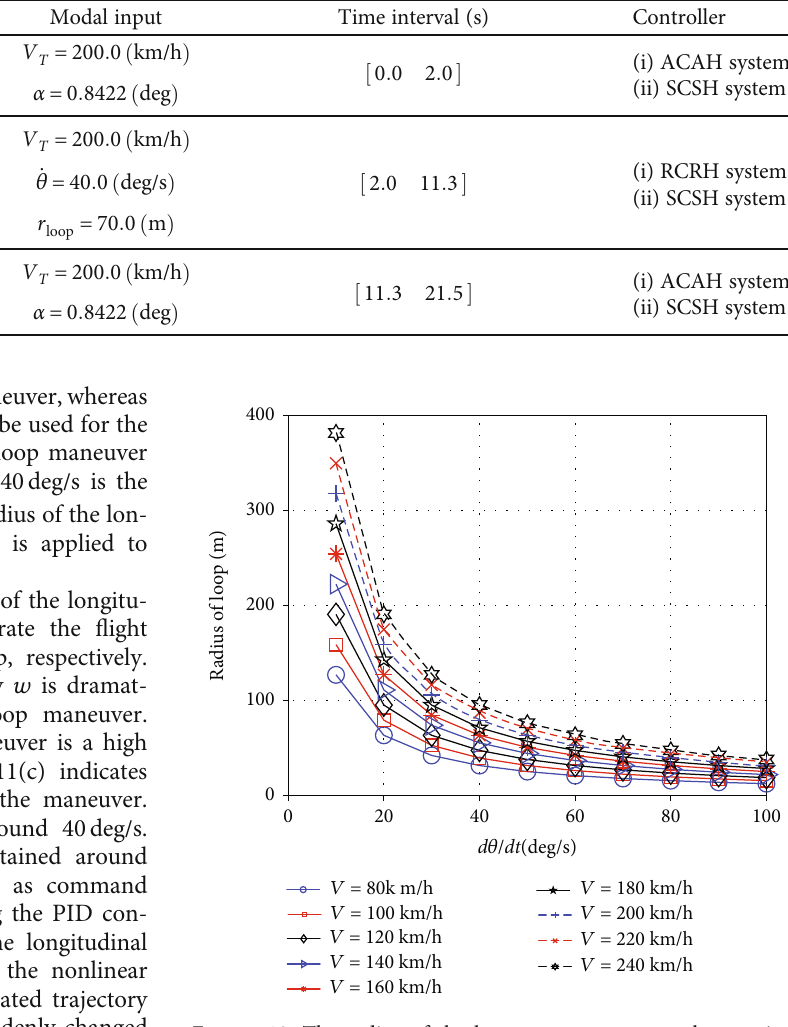
Figure 10: The radius of the loop maneuver versus the rotation speed